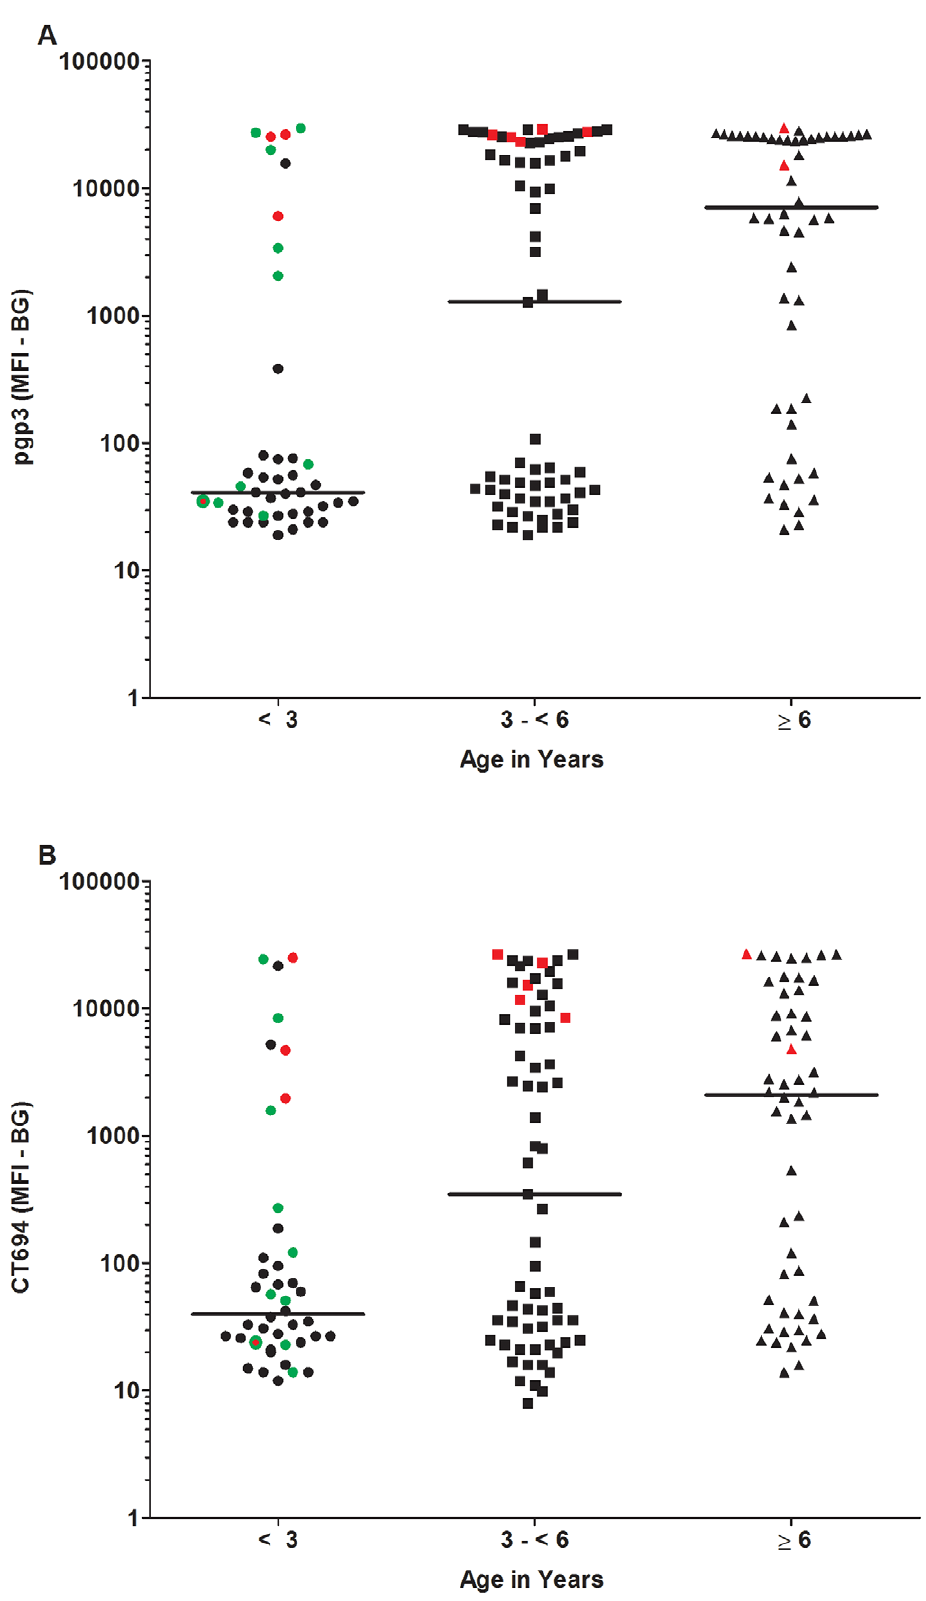
Figure 4. Antibody response in association with age. Median responses are shown in median fluorescence intensity minus background (MFI- BG) for (A) pgp3 and (B) CT694 antibody positive responses by age ranges of less than 3 years old (n=42), between 3 and less than 6 years old (n=65), and 6 years or older (n=52). Responses shown in red indicate PCR positivity. Responses in green are children with ocular pathology (shown